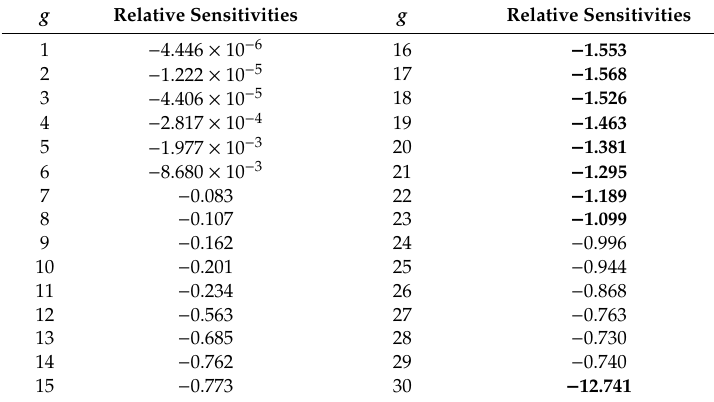
(cid:16) (cid:17) N 2,1 , σ g , g = 1, ... ,30. t ,6